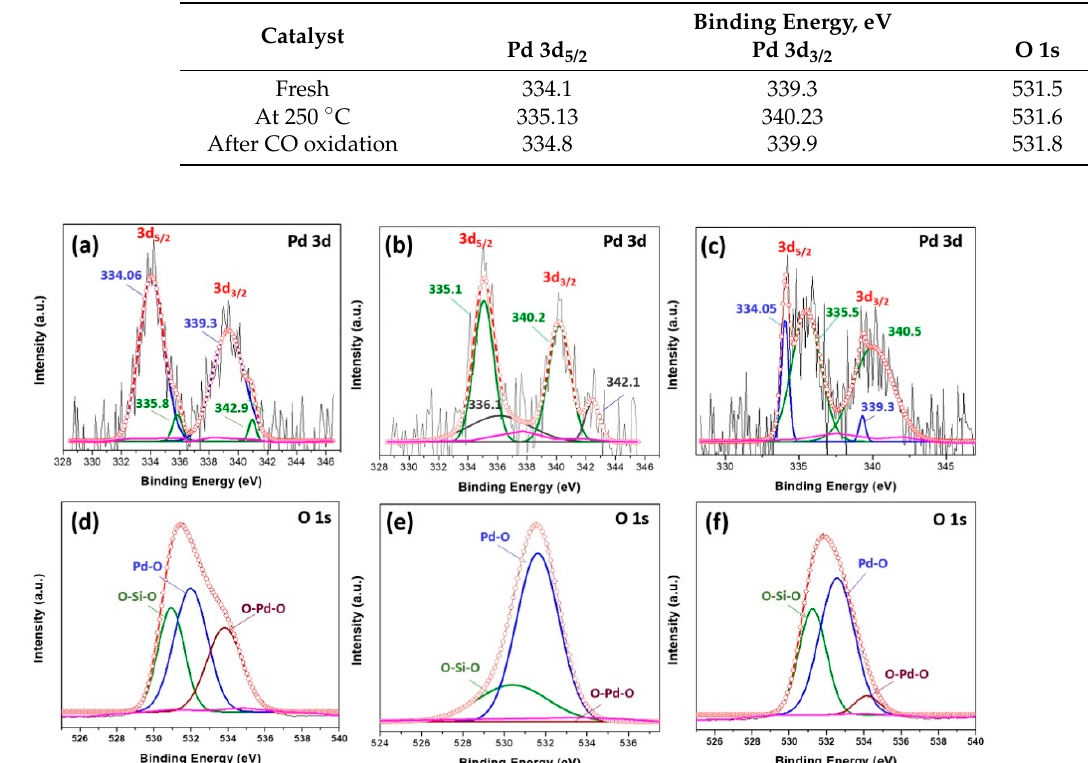
Table 3. List of the binding energies of palladium species (Pd and PdO) and the binding energy of the corresponding O 1s peak located in the near-surface region of Pd/SiO 2 catalysts.